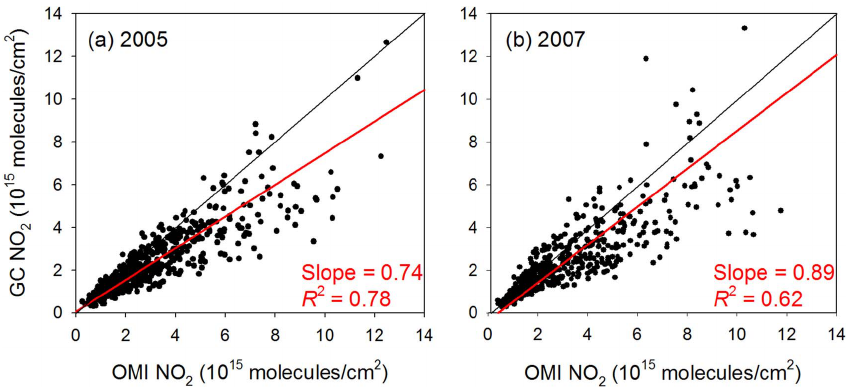
Fig. 4. Comparisons between GEOS-Chem and OMI summer average tropospheric NO 2 columns for (a) 2005 and (b) 2007 over grids with power plants in China. RMA algorithm is used in the linear fitting (red line).